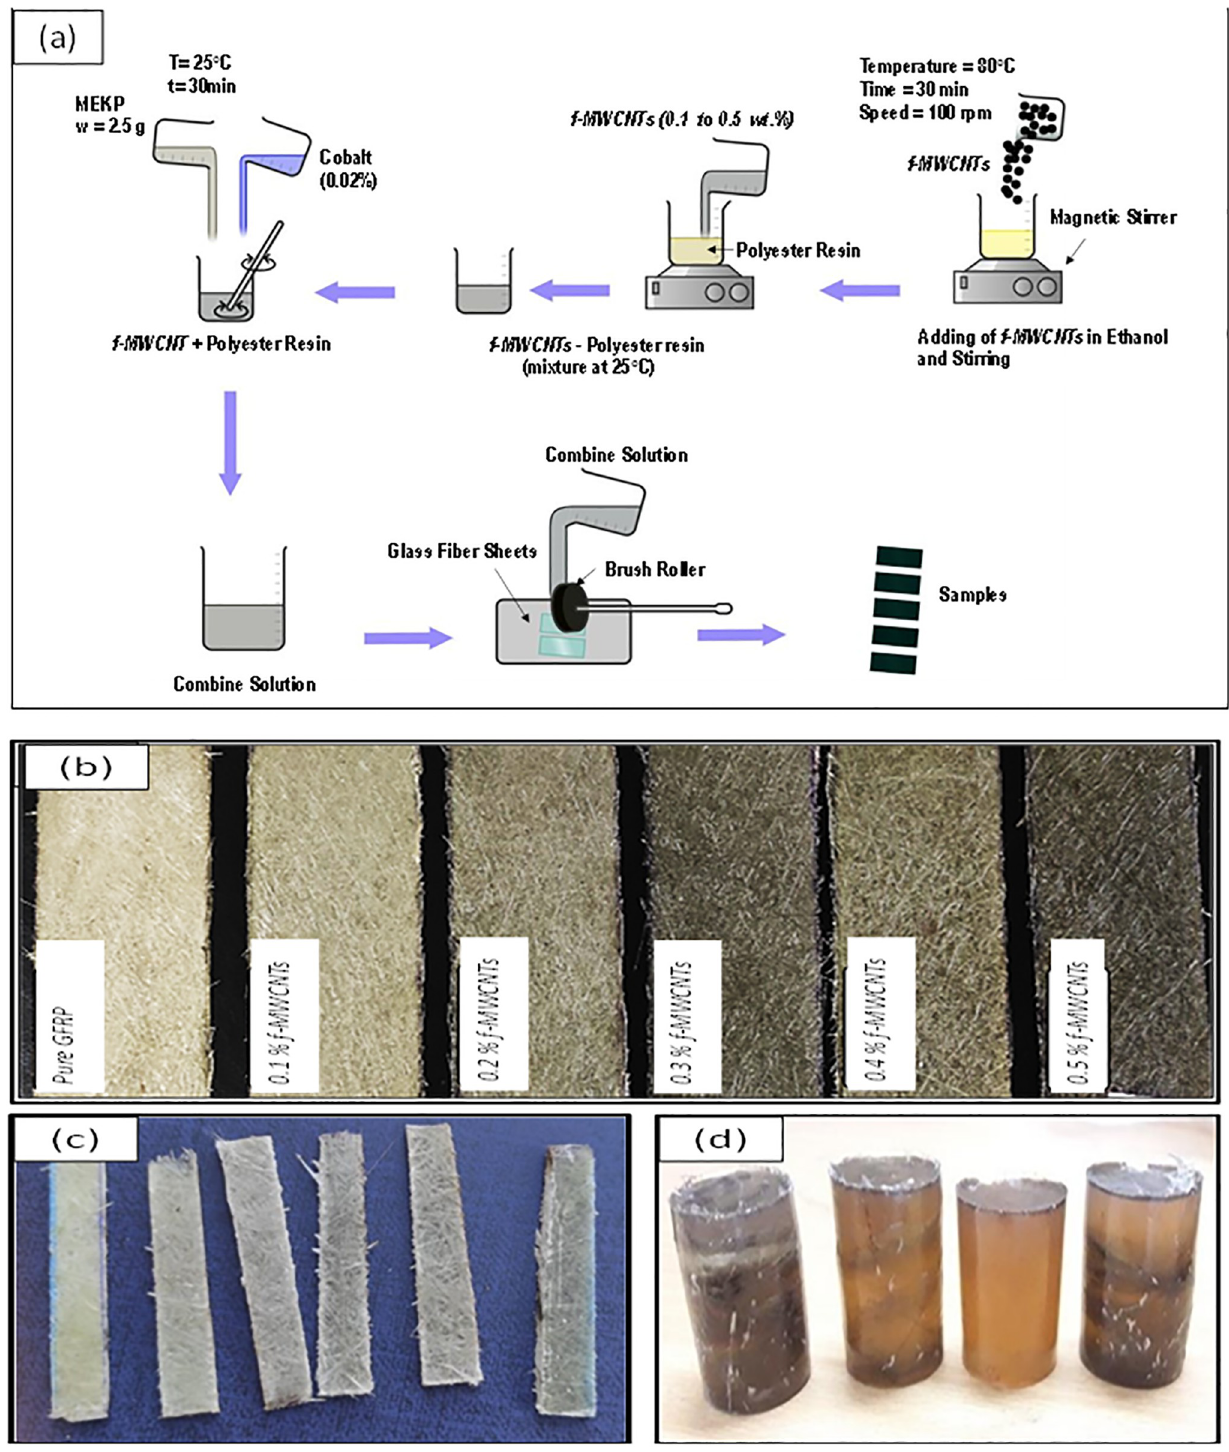
Fig 2. (a) Schematic of the sample preparation, (b) developed GFRPs samples modified, (c) samples for impact strength tests, (d) samples for compressive strength tests.